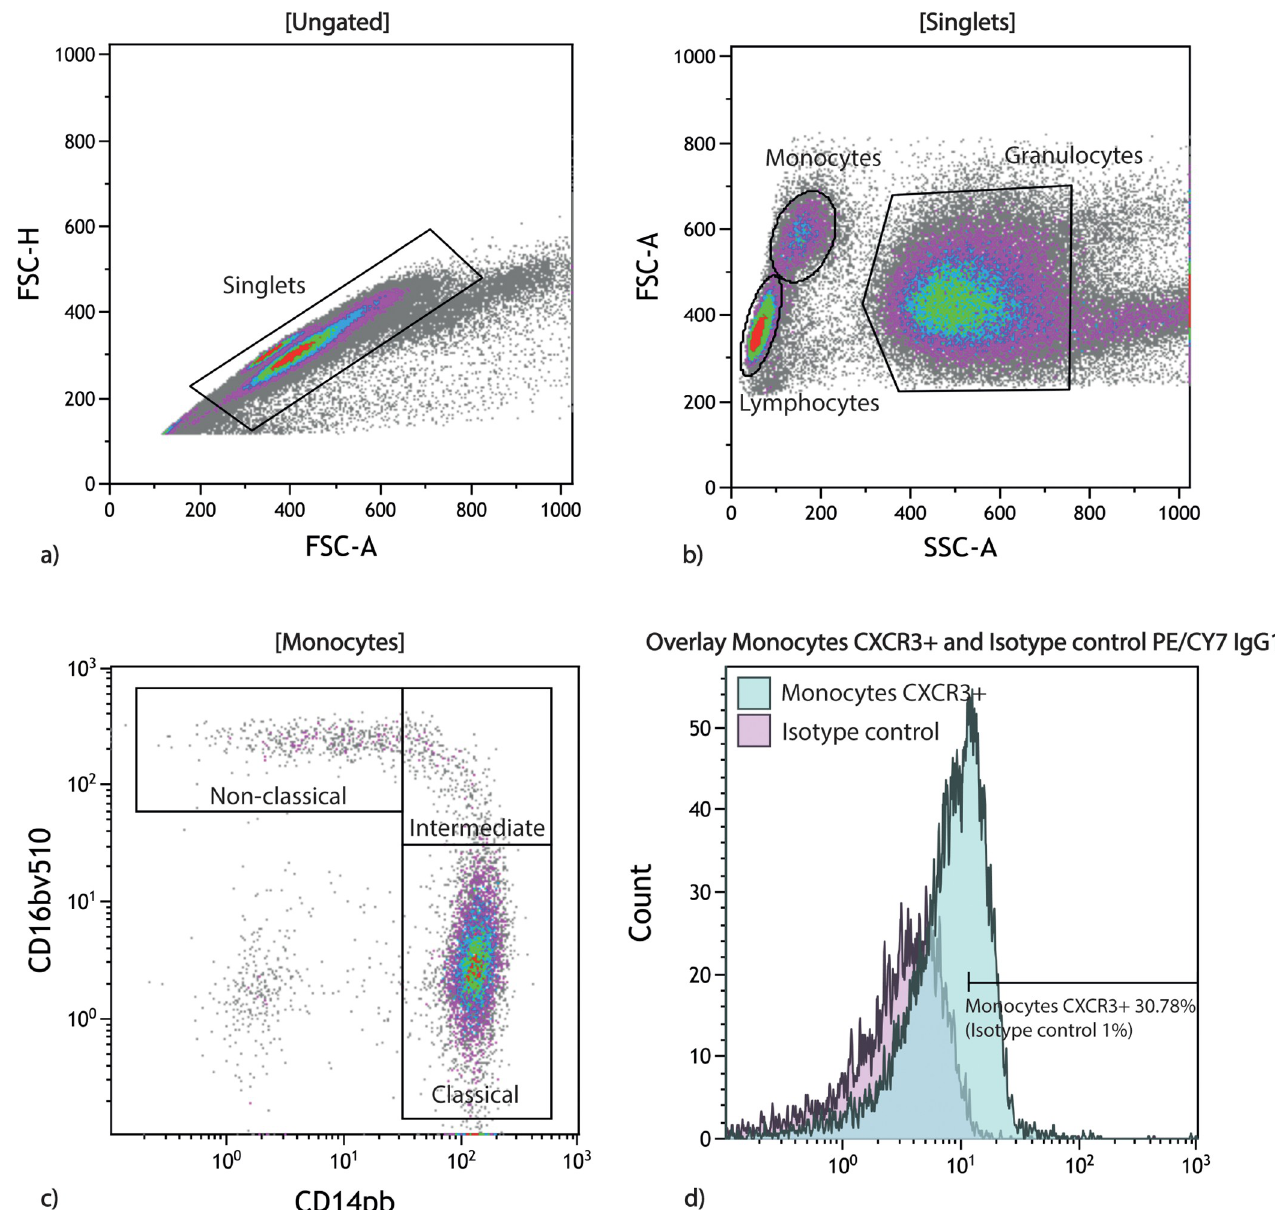
Fig 1. Gating strategy for identifying CXCR3 expression on monocytes using Kaluza software. a) First, we identified Singlets using forward height vs. area scatter. b) Next, we identified monocytes using a forward side scatter plot. c) Monocyte subsets were identified using the markers CD14 and CD16 (classical monocytes CD14 + CD16 - , intermediate monocytes CD14 + CD16 + , and non-classical monocytes CD14 - CD16 + ). d) Finally, we used a negative isotype control (set to 1%) to distinguish the CXCR3 positive monocytes (shown in the overlay plot). The same procedure was done for lymphocytes, using the markers CD4 + and CD8+ for identifying CD4+ and CD8+ T cells.